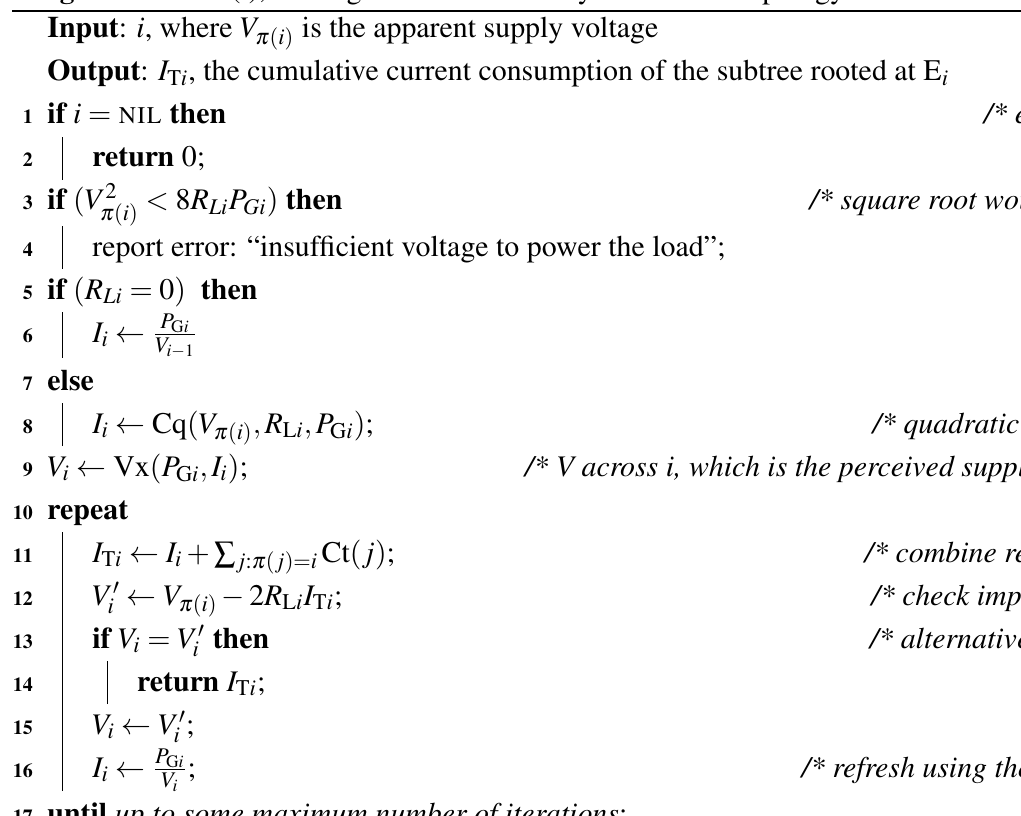
Algorithm 2: Ct( i ), solving current recursively for the tree